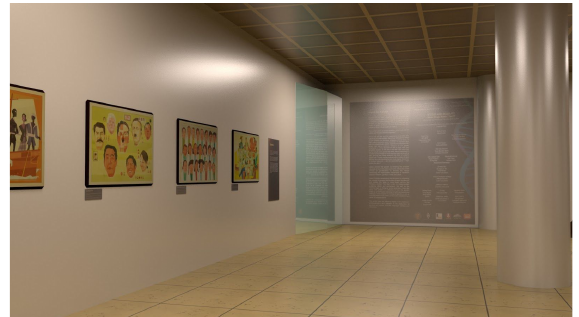
Figure 4. VR Environment near the entrance